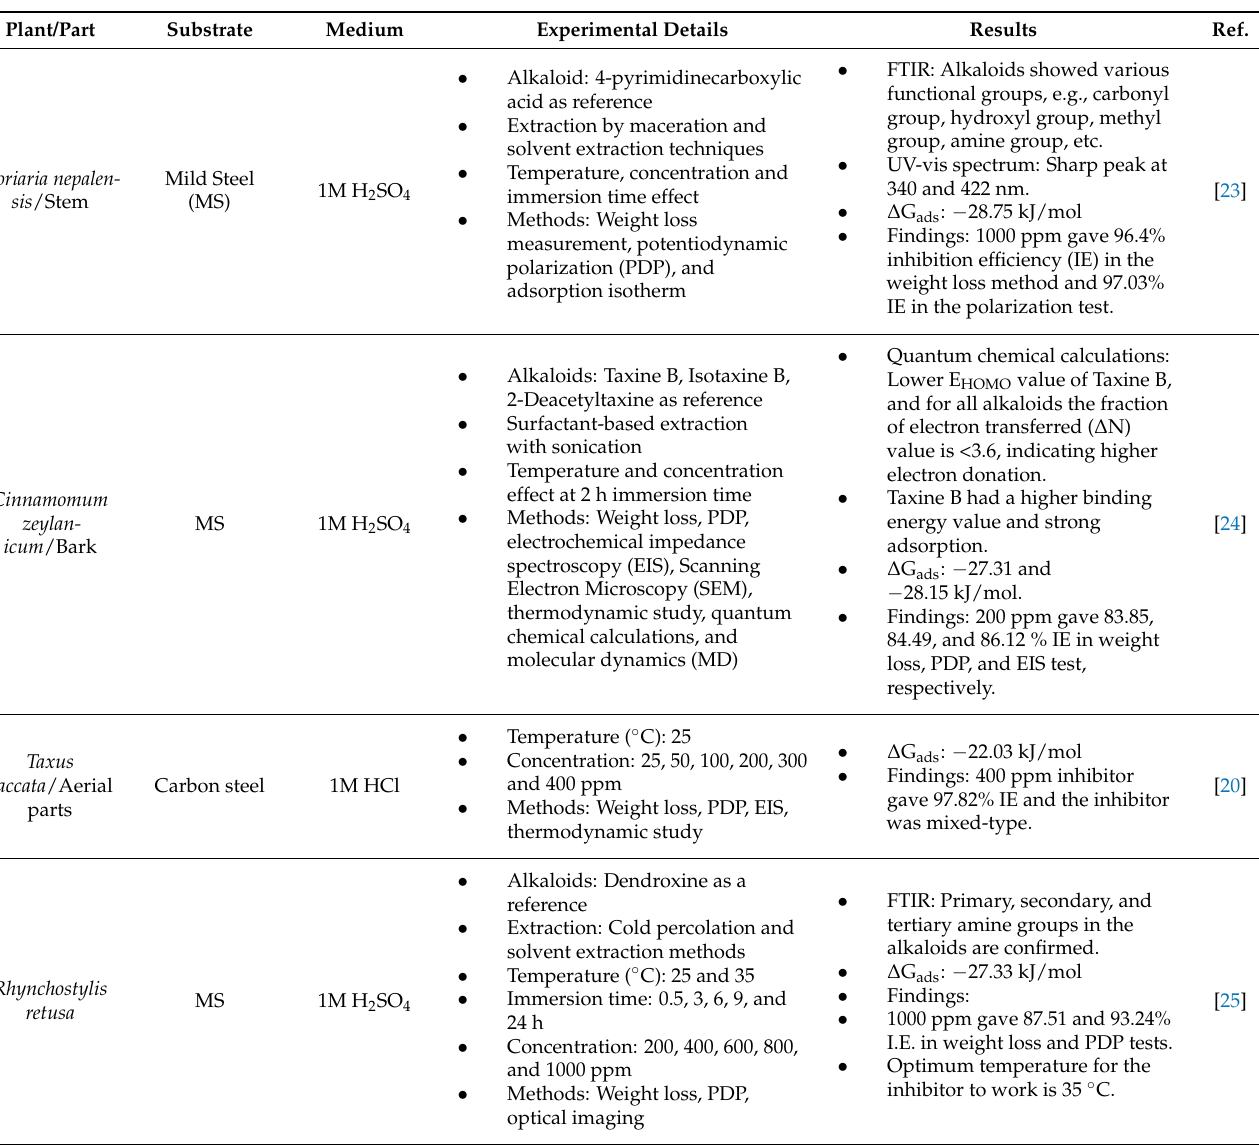
Table 1. Some of the literature on alkaloids as green corrosion inhibitors from 2020 to 2022